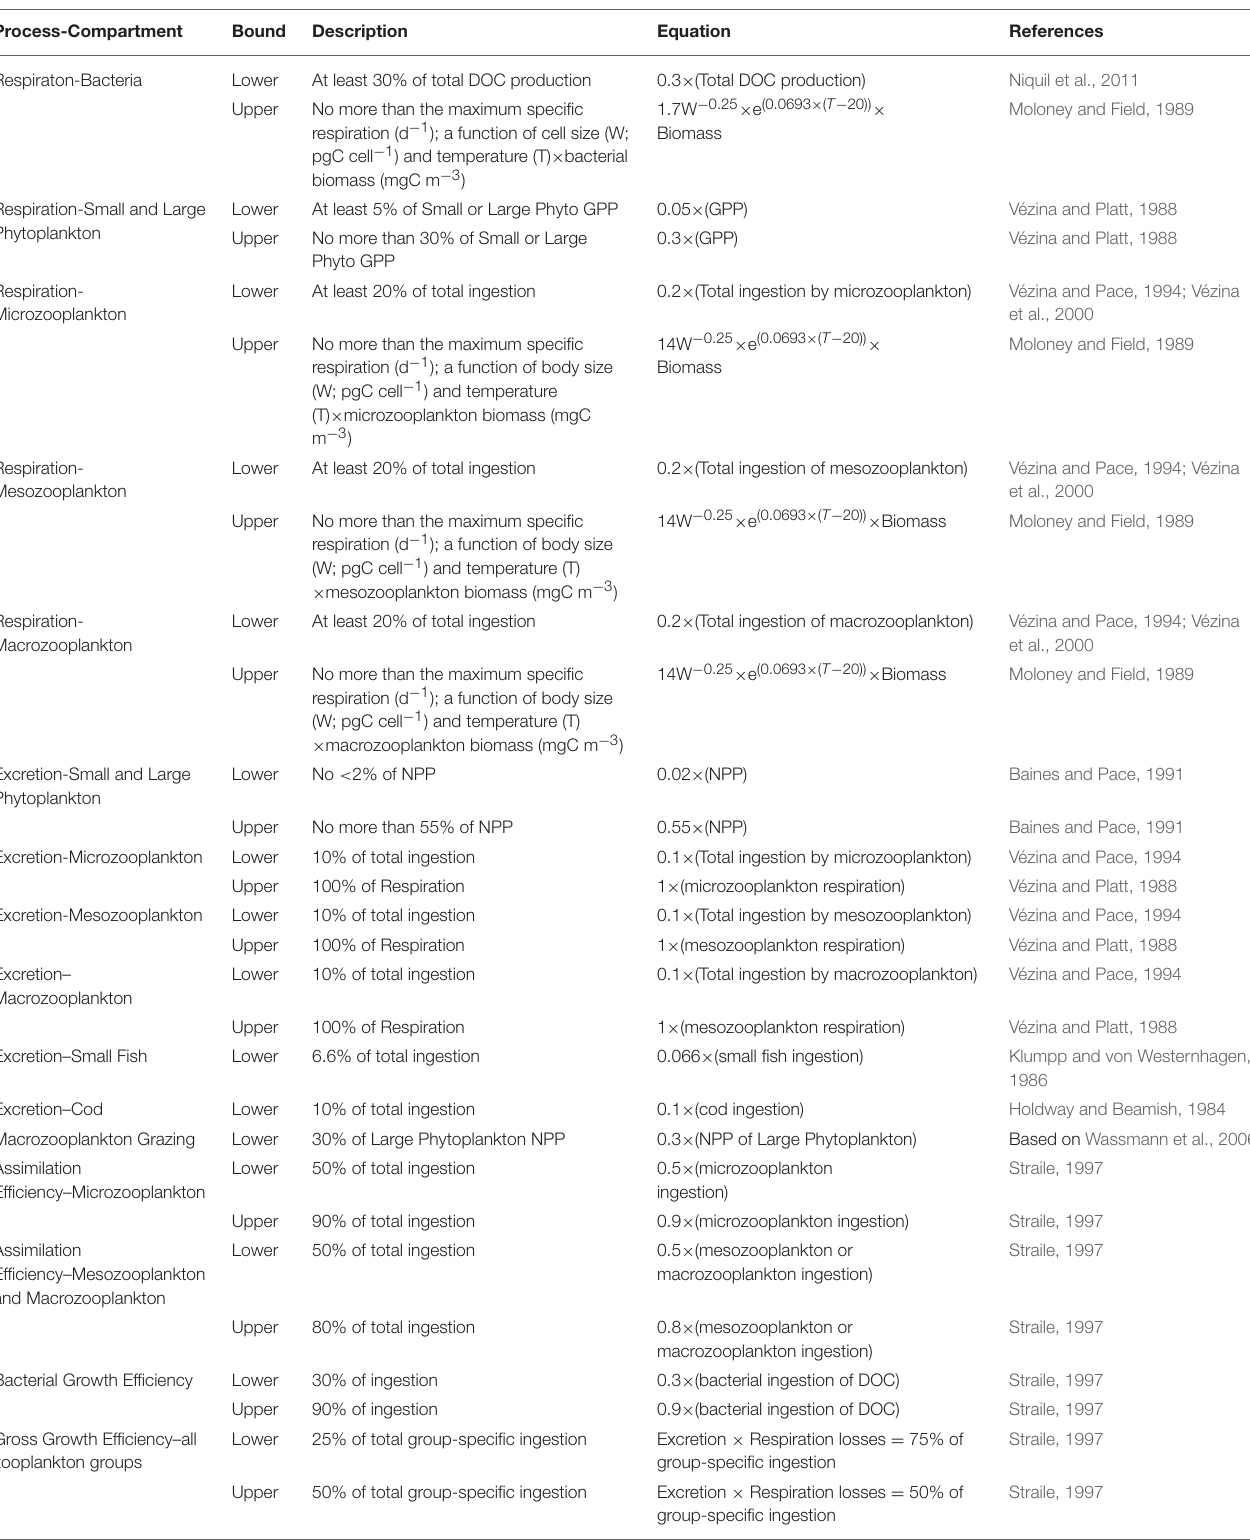
TABLE 4 | Constraints on carbon flows for the inverse